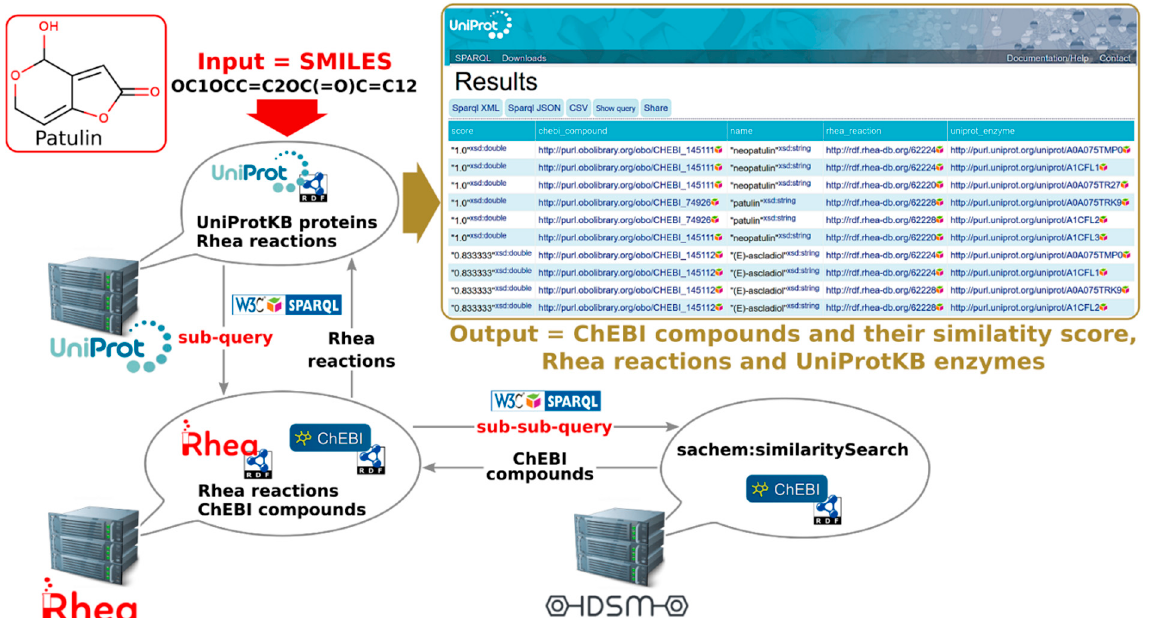
Figure 5. Graphical representation of the sample federated SPARQL query displayed in Figure S7 and its results. The query is performed at the UniProt SPARQL endpoint, which first “calls” the Rhea SPARQL endpoint, which itself “calls” the IDSM SPARQL endpoint. The actual compound similarity search (sachem:similaritySearch) is performed by the IDSM endpoint, which returns ChEBI compounds identical or similar to patulin to the Rhea endpoint. The Rhea endpoint then assembles a list of matching reactions and passes this list back to the UniProt endpoint, which finally maps the reactions to all possible enzymes and creates the desired result set of cognate chemicals, reactions, and enzymes. The results are available at tinyurl.com/sparql-uniprot.